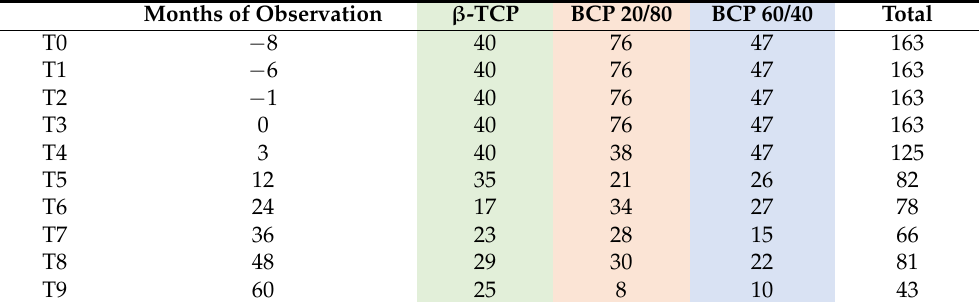
Table 3. Number of measurements available at several time points up to 5-year follow-up. β